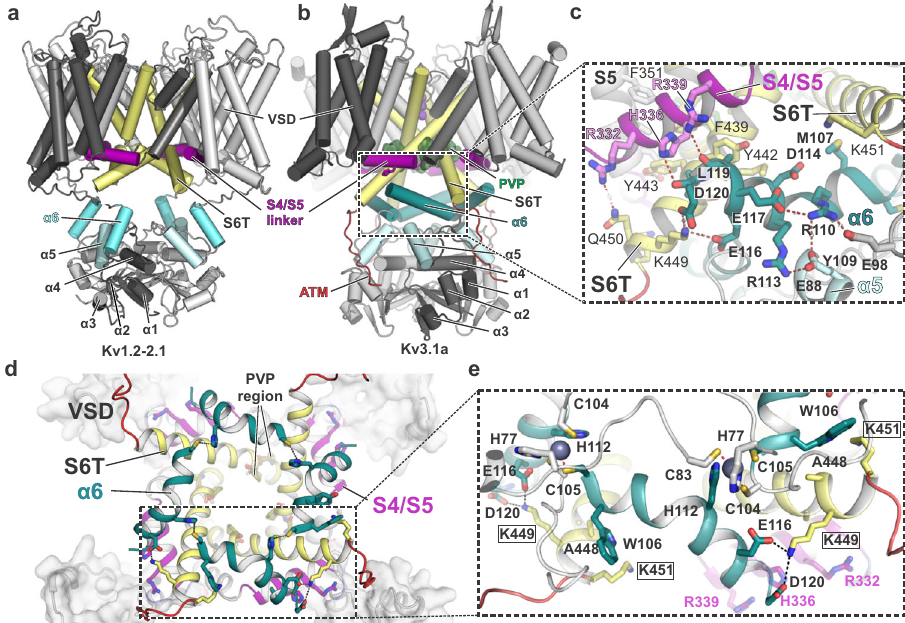
Fig. 4 The α 6 helix of the Kv3.1 T1 domain forms a second cuff below the S4/S5 linker, stabilized by inter- and intrasubunit interactions. a Cartoon representation of the Kv1.2-2.1 tetramer (light grey) with one protomer highlighted in dark grey. S4/S5 linker is represented in magenta, S6 is coloured in pale yellow and α 6 of the T1 domain is shown in aquamarine blue. b Cartoon representation of the Kv3.1a tetramer, illustrating the unique orientation of α 6 (teal blue) of the T1 domain. Colour-coding of other elements is the same as in ( a ). c Inset from b with an enlarged view of the α 6 helix and its interactions with residues in the S4/S5 linker (magenta) and the lower gate formed by S6T (pale yellow). d Cytoplasmic view of the tetrameric “ α 6 gating cuff ” (shown as teal cartoon), located below the gating machinery formed by S4/S5 (magenta) and S6T (yellow). Only helix α 6 of T1 is shown for clarity. e Inset from d , detailing inter-subunit interactions between α 6 helices from adjacent subunits and interactions between α 6 and S6T. Zn 2 + ions are shown as grey